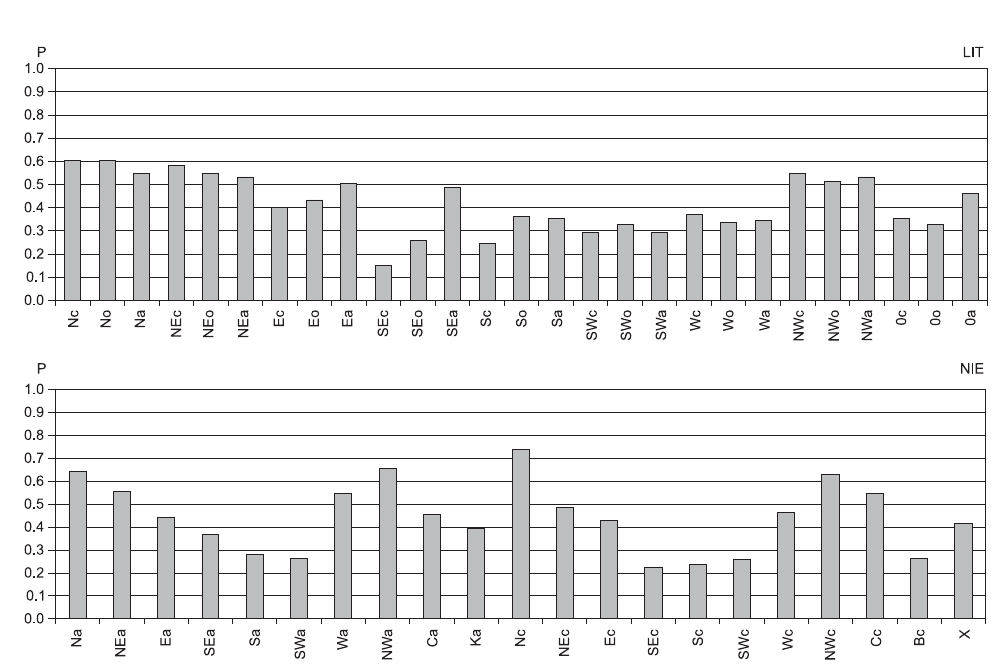
Fig. 5. Conditional probability of late spring freezes (May–June) by circulation